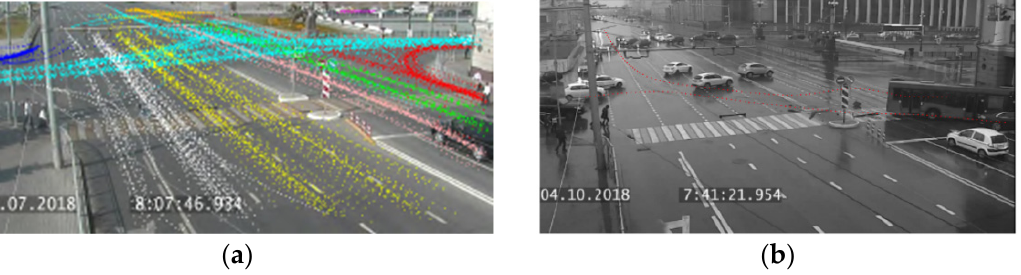
Figure 12. Examples of normal and anomalous clusters. ( a ) Normal clusters. ( b ) Anomalous clusters (traffic accident).